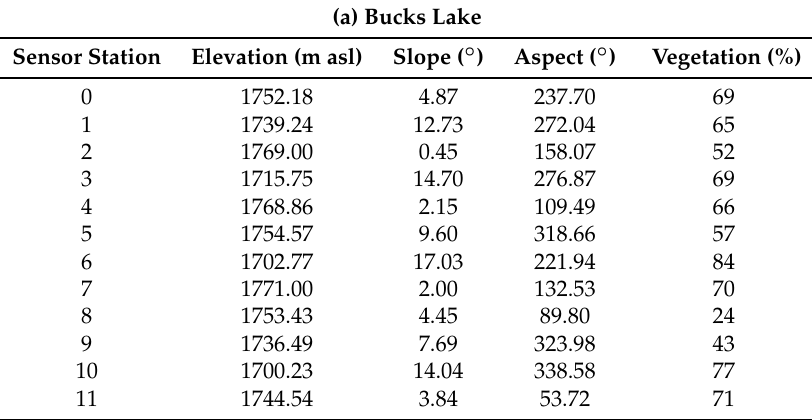
Table 3. Sensor station